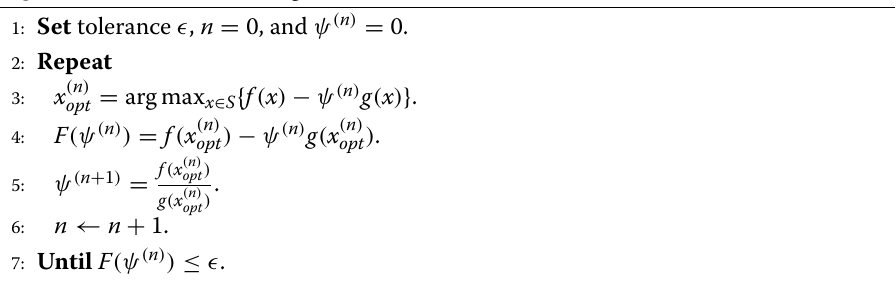
Algorithm 2 Dinkelbach’s Algorithm